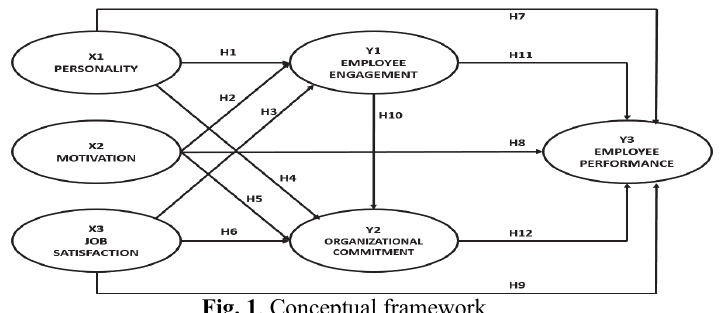
Fig. 1 . Conceptual